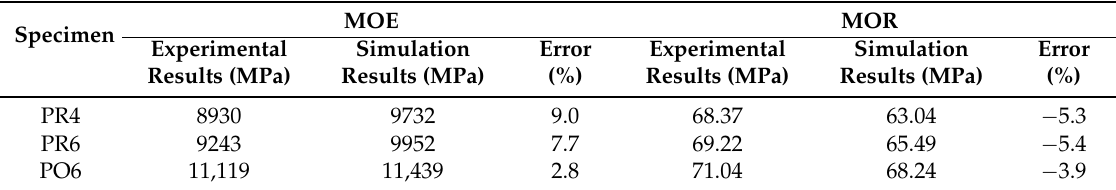
Table 6. MOE and MOR of Cathay poplar glulam from the test and simulation results.